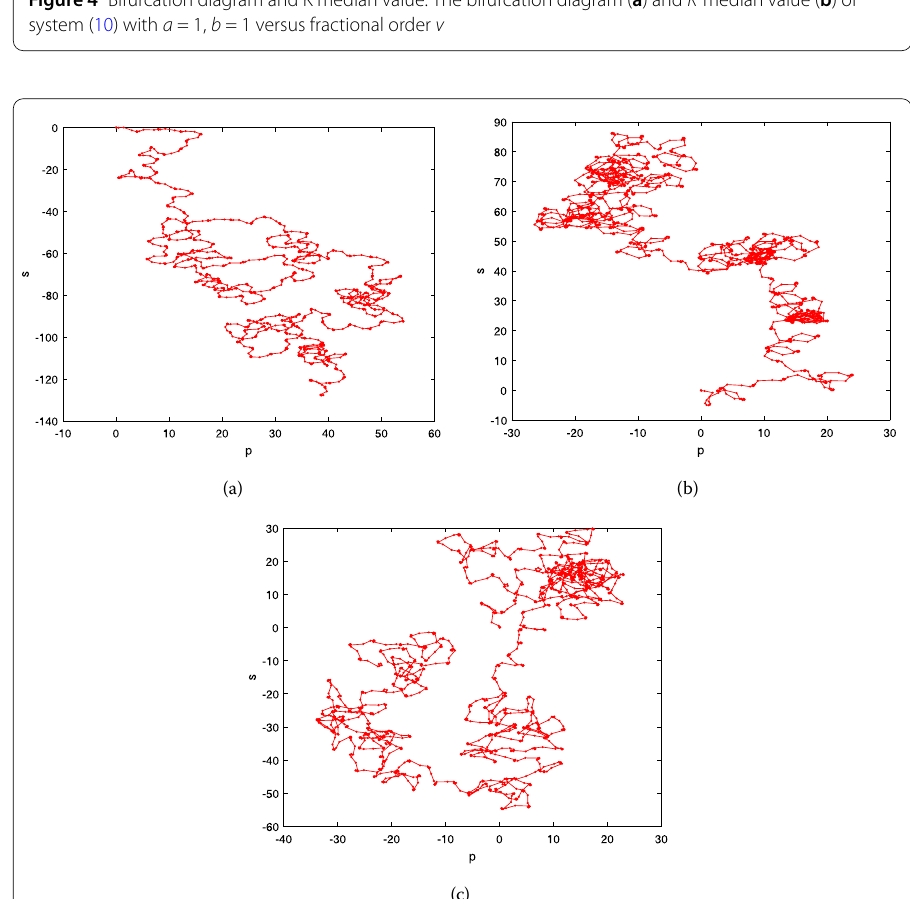
Figure 5 The 0–1 test:( p , s ) dynamics. The 0–1 test: ( p , s ) dynamics of system (10), ( a ) a = 1, b = 0.85 and v = 0.9, ( b ) a = 0.7, b = 0.9 and v = 0.9, ( c ) a = 1, b = 1 and v = 0.85, respectively